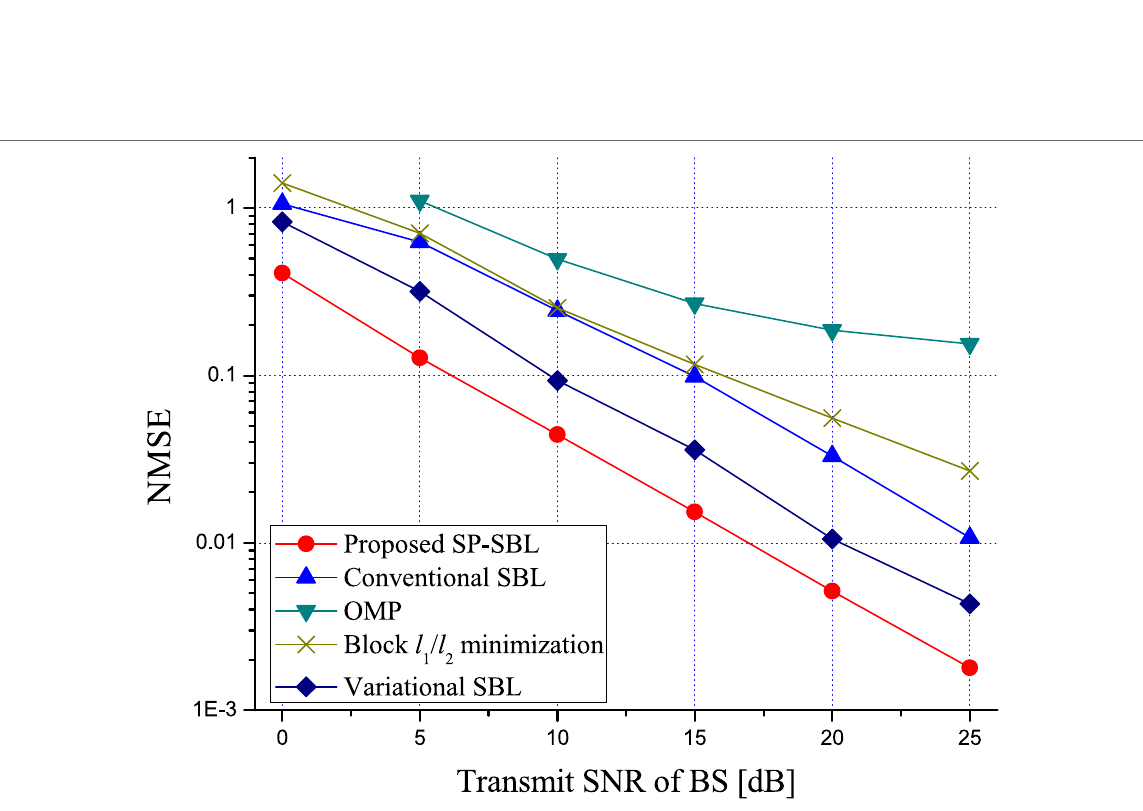
Fig. 4 NMSE performance for different transmit SNRs of BS, where N = 64 and M = 4. The length of pilot sequence is T = 16 and the angular spread is (cid:3) d = 5 ◦ . The angular-domain channel is assumed exactly